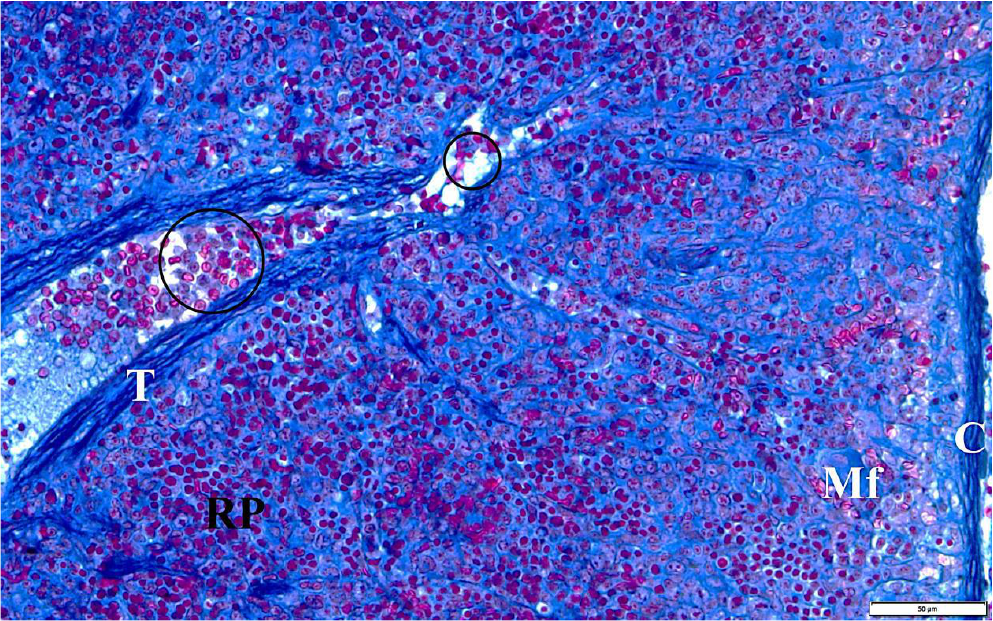
Figure 9. The spleen of a rat with transplacental infection with B. microti 3 weeks after birth. C—fibrous capsule, Mf—macrophage, RP—red pulp, T—trabecula with a trabecular vessel, circular markings—longitudinal sections through trabecular vessels with multicolored erythrocytes and congestive changes.